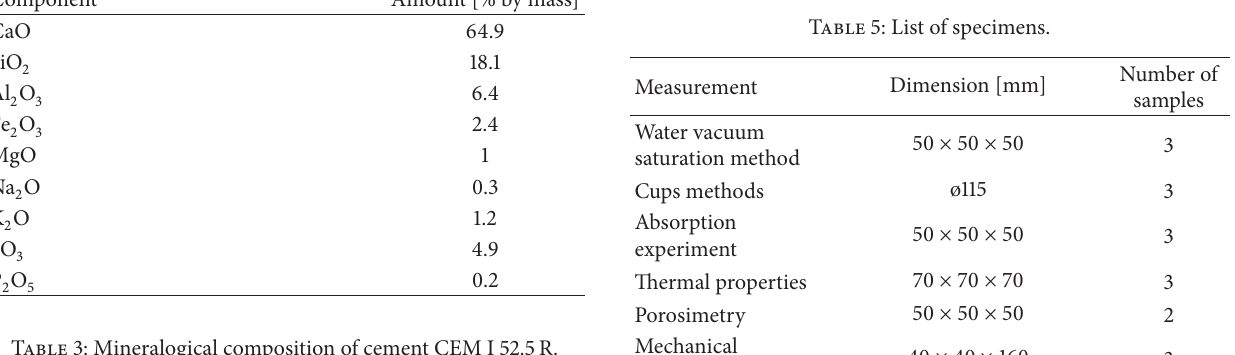
Table 3: Mineralogical composition of cement CEM I 52.5 R. Component